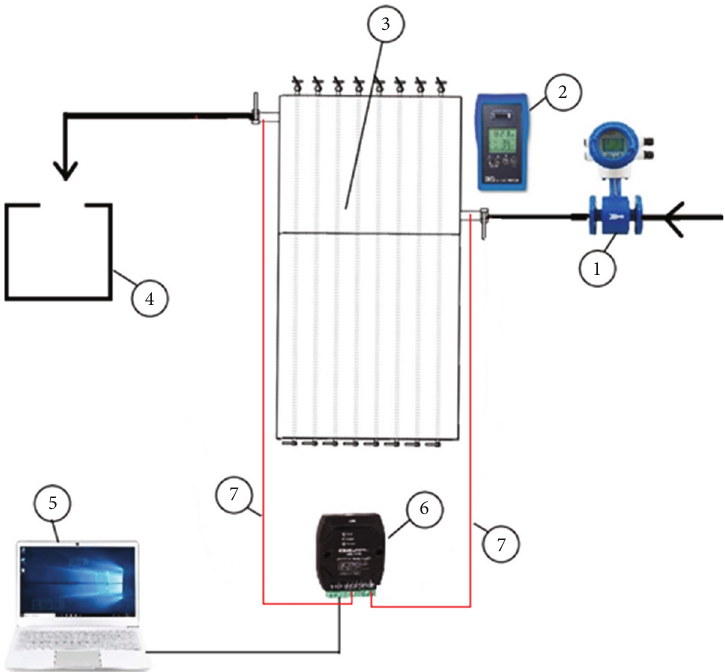
Figure 5: Scheme of the experimental setup (1: fl ow meter; 2: pyranometer; 3: heat pipe solar collector; 4: tanks; 5: computer; 6: data collection card; 7: thermocouple).